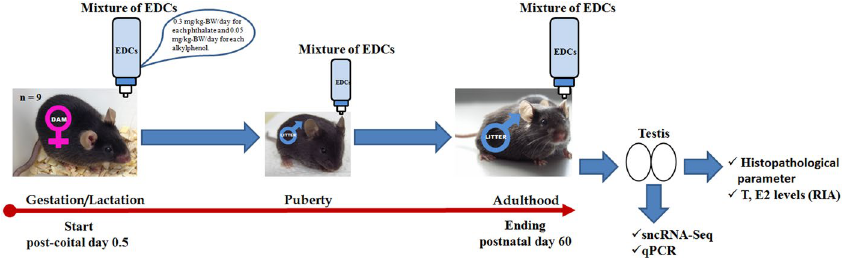
Figure 1. Schematic diagram of the experimental design. C57BL/6J mice were treated as described in the material and methods section. Mice chronically exposed to EDCs-mixture and control mice were sacrificed on postnatal day 60 at which testes were harvested. We quantified intratesticular testosterone and estradiol levels by RIA, histological alterations, expression of mRNAs by RT-qPCR and miRNAs/isomiRs expression by sncRNA- Seq and